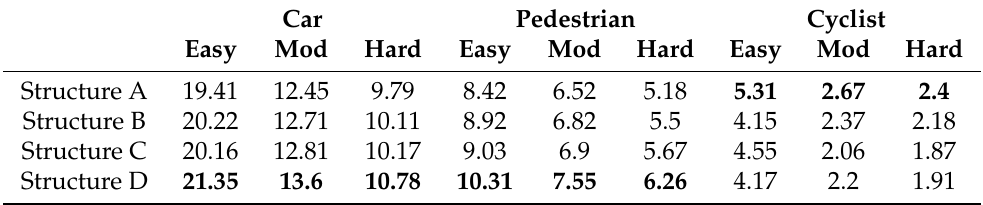
Figure 16. Different shape-aware convolution. We show the illustration of structure A ( a ), structure B ( b ), structure C ( c ), and structure D ( d ). Table 8. The comparison of the AP 40 among four shape-aware convolution structures in Figure 16 on the 3D object detection task on the KITTI validation set. We use bold type to indicate the best